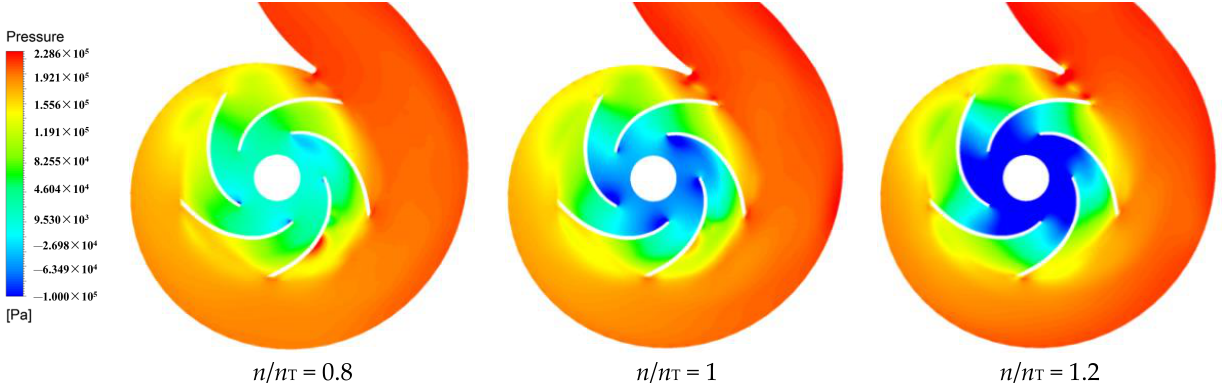
Figure 12. Pressure distributions in the pump.